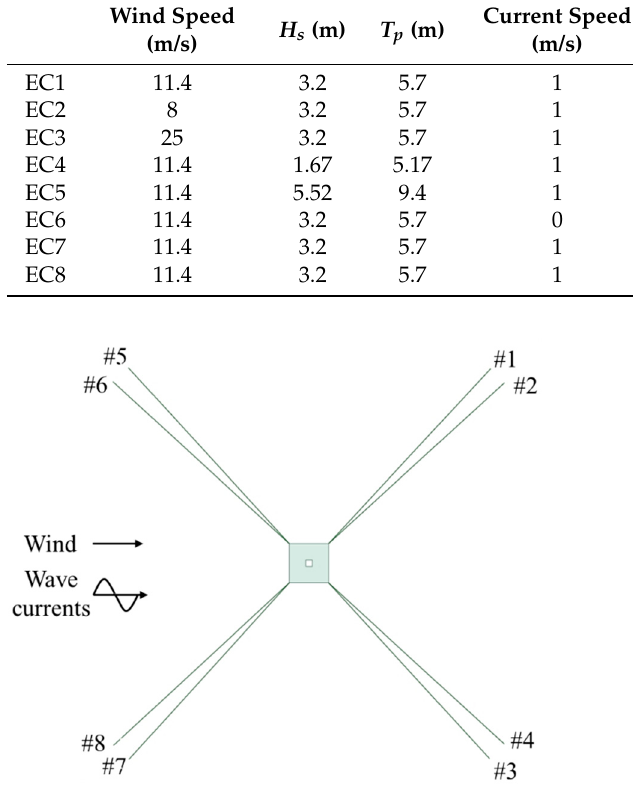
Figure 9. The schematic layout of mooring line 1 to